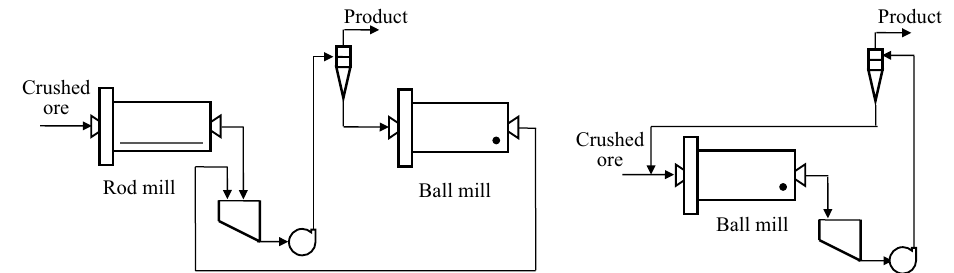
Fig . 2. Schematic overview of typically two-stage grinding process, based on the use of rod and ball mills